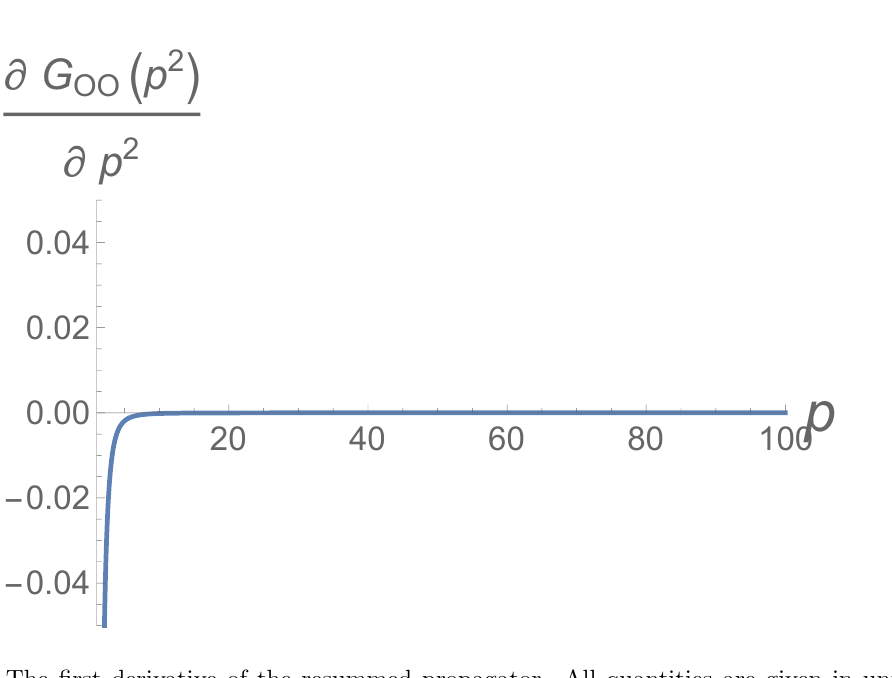
Figure 5 . The (cid:12)rst derivative of the resummed propagator. All quantities are given in units of appropriate powers of the energy scale (cid:22) , with the parameter values e = 1, v = 1 (cid:22) , (cid:21) = 1 so